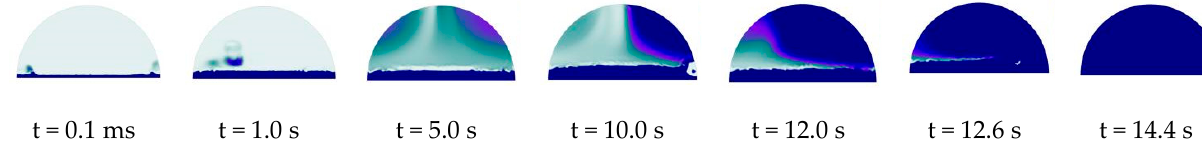
Figure 19. Freezing of the water droplet at 253.15 K.